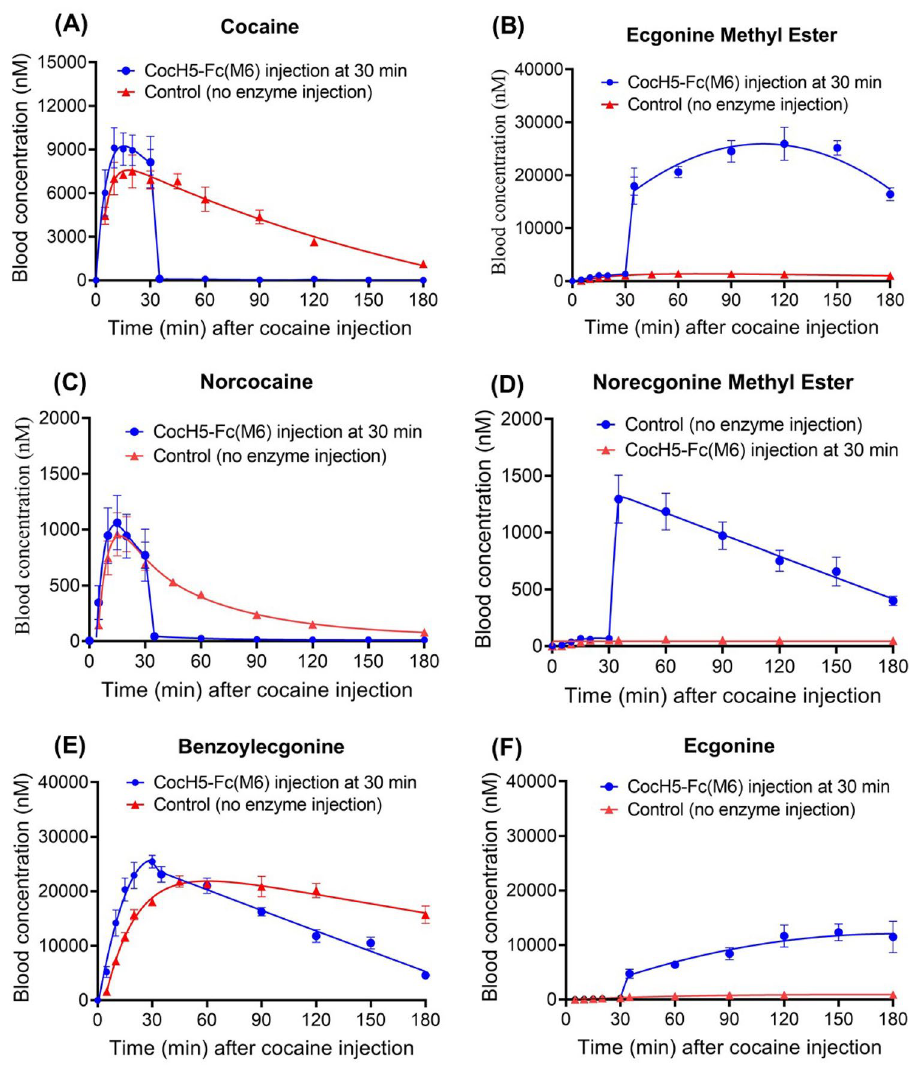
Figure 6. Time-dependent concentrations of ( A ) (-)-cocaine, ( B ) ecgonine methyl ester (EME), ( C ) norcocaine, ( D ) norecgonine methyl ester, ( E ) benzoylecgonine, and ( F ) ecgonine. 1 mg/kg CocH5-Fc(M6) was administered (IV) at 30 min after IP administration of 60 mg/kg cocaine for the treatment rats (n = 4). The corresponding data for the control rats were reported previously 45